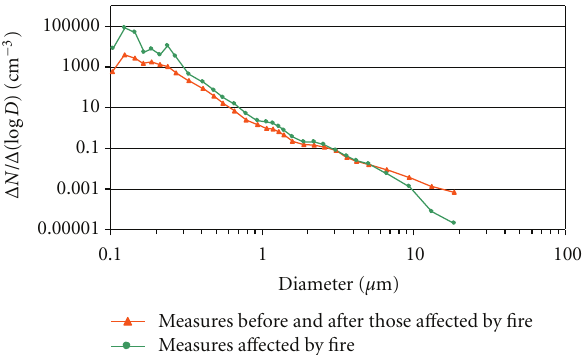
Figure 9: Mean size distributions of the measurements carried out immediately before and after those a ff ected by wildfires and of the a ff ected measurements during the months of June, July, August, and September